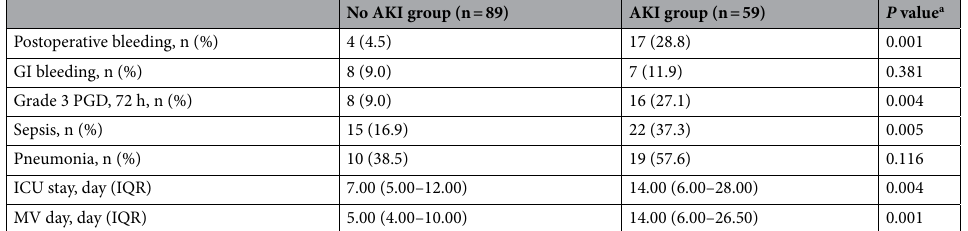
Table 3. Postoperative complications among lung transplant recipients according to AKI. Data are presented as number (%) or medians (interquartile ranges). GI bleeding gastrointestinal bleeding, PGD primary graft dysfunction, ICU intensive care unit, MV mechanical ventilation. a P value determined by t test or χ 2 test.